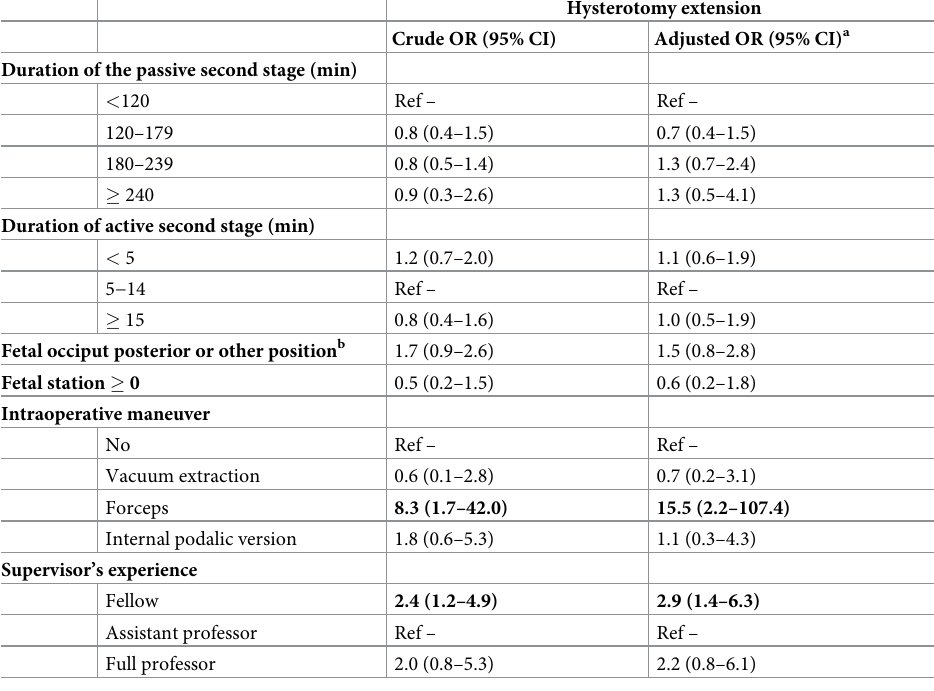
Table 4. Risk factors for incision extension during the second stage of labor and cesarean delivery—crude and adjusted odd